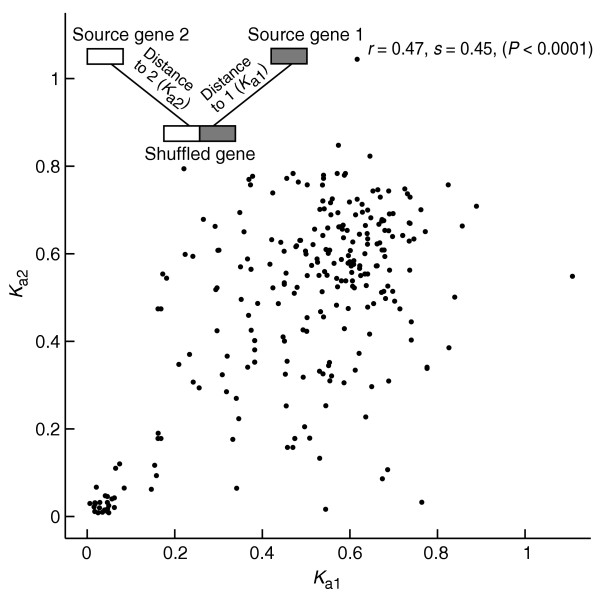
Similarity in sequence divergence between regions of shuffled genes. The amino-acid divergences (Ka) of recombined domains to their respective parental counterparts are correlated. One outlying observation (Ka1 = 3.26 and Ka2 = 0.36) is not shown in this plot but was included in the calculation of correlation coefficients. Excluding this observation increases the Pearson correlation coefficient to 0.61 and leaves the Spearman correlation coefficient unchanged (P < 0.0001 for both).